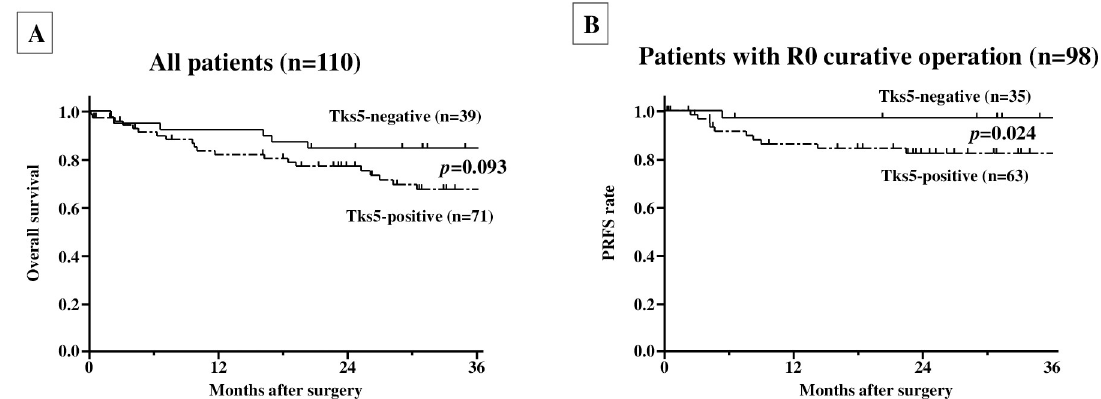
Fig 2. Survival. A, Overall survival of 110 gastric cancer patients based on Tks5 expression in peritoneal mesothelial cells. No significant difference was found between the Tks5-positive and -negative groups ( p = 0.093). B, Peritoneal recurrence-free survival of 98 gastric cancer patients based on Tks5 expression in peritoneal mesothelial cells. The 3-year PRFS of the Tks5-positive group was significantly worse than that in Tks5-negative group ( p = 0.024).